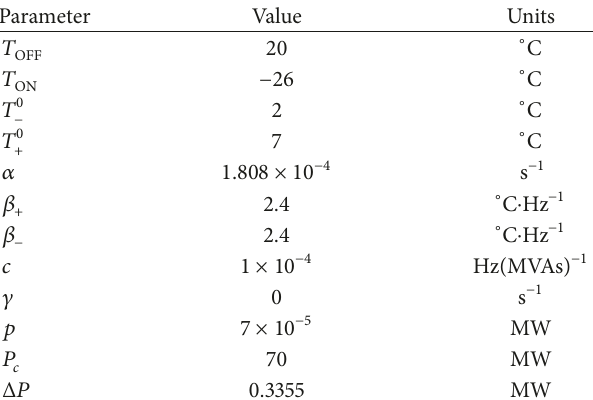
Table 2: Parameter values assumed, unless stated